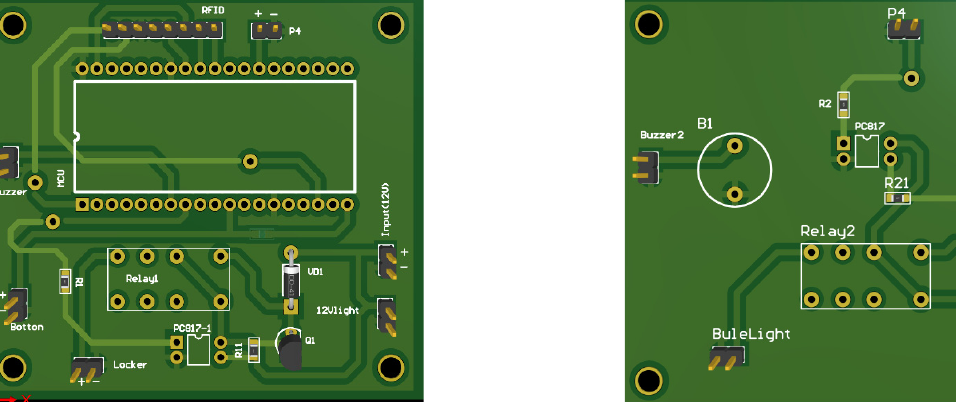
Figure 22. PCB layout of lower and lower layers of the control board of the key cabinet.